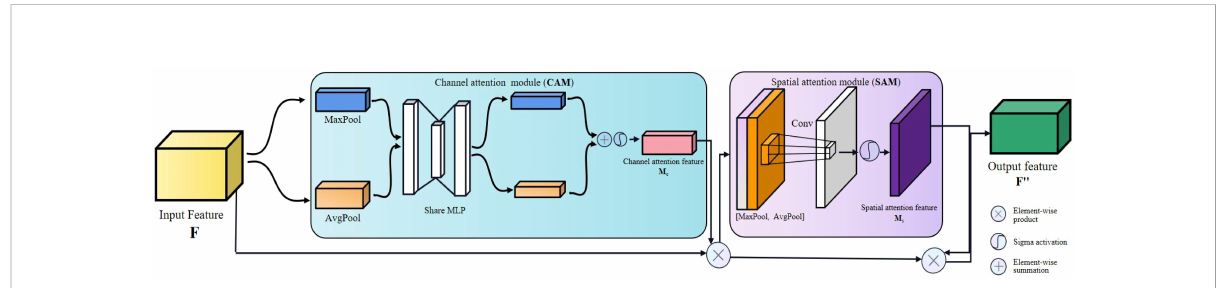
FIGURE 7 Structure diagram of the convolutional block attention module